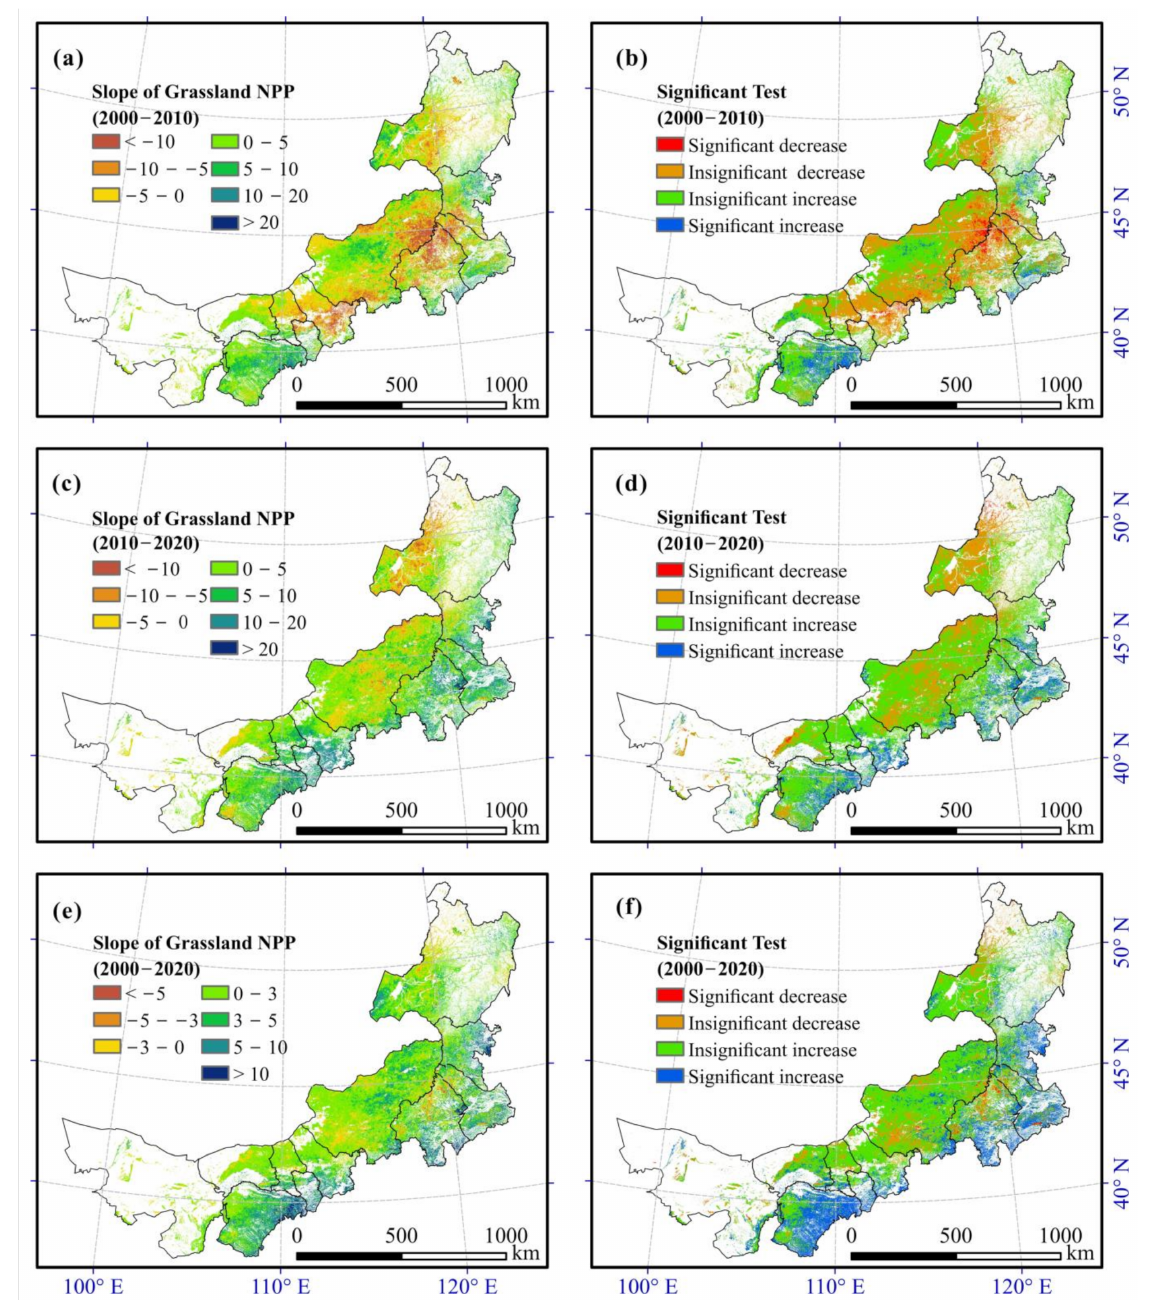
Figure 9. Spatial distribution of the slope of grassland NPP obtained by the Theil–Sen method ( a , c , e ) (unit: g C/(m 2 · yr)) and its significance by the MK test ( b , d , f ) ( α = 0.05) in Inner Mongolia during the different